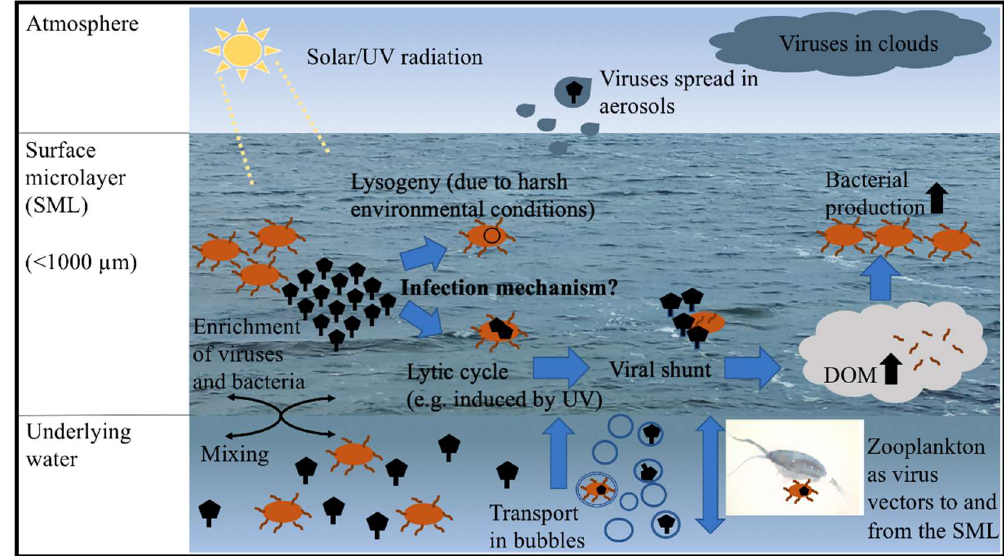
Figure 1. Viral–bacterial dynamics in the surface microlayer (SML) and beyond. DOM = dissolved organic matter, UV = ultraviolet.